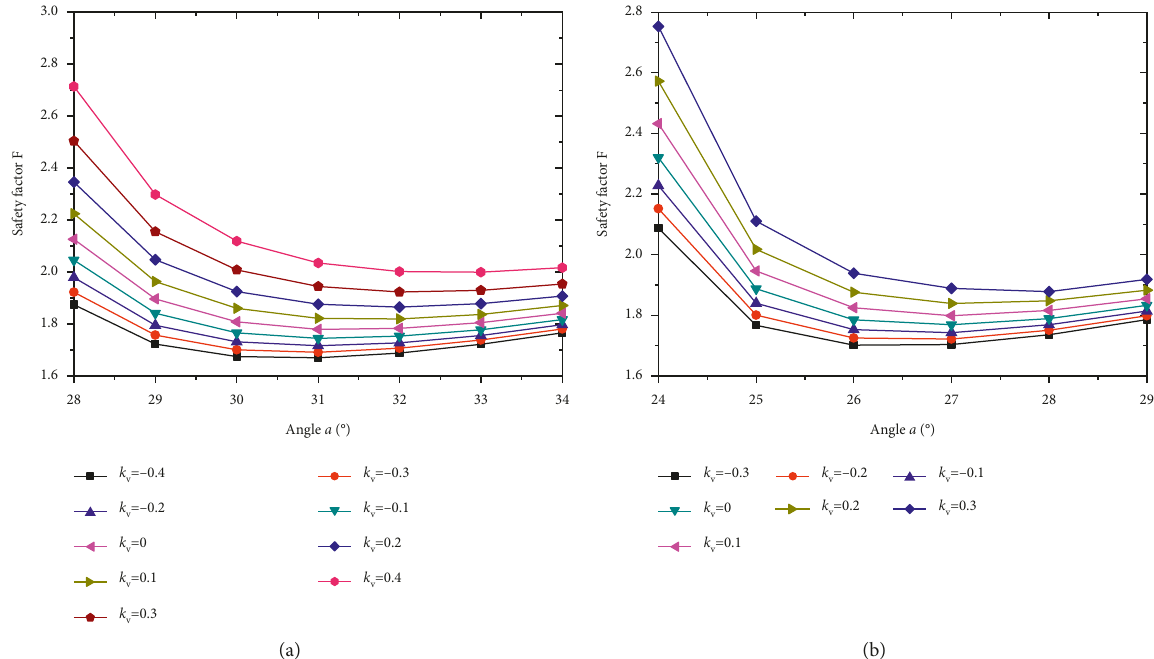
Figure 11: Effect of vertical seismic acceleration coefficient on safety factor F and inclination angle α . (a) Result of case 1 ( h � 2m). (b) Result of case 2 ( h � 3